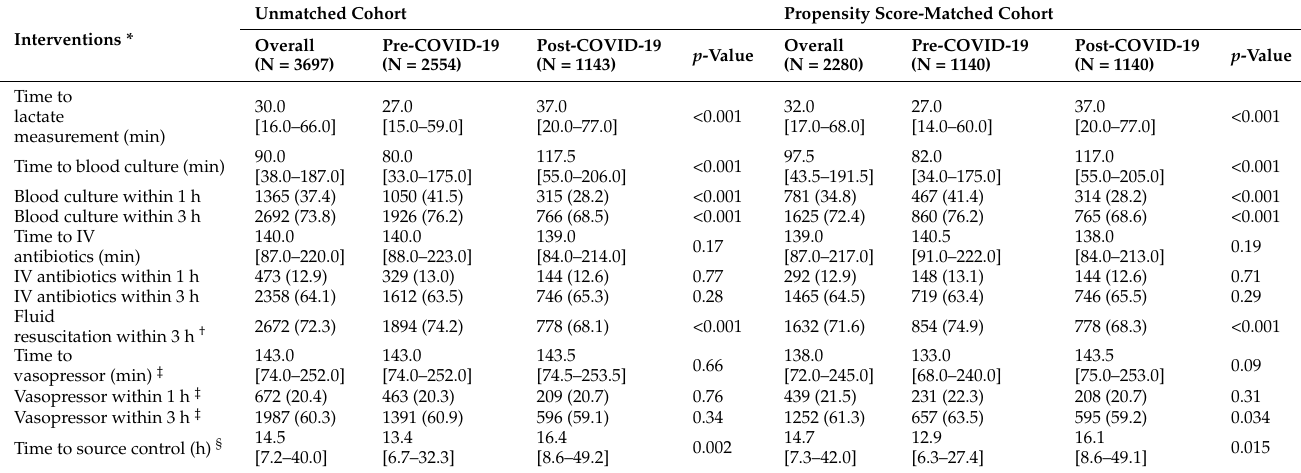
Table 3. Sepsis-related interventions of unmatched and propensity-matched cohorts.